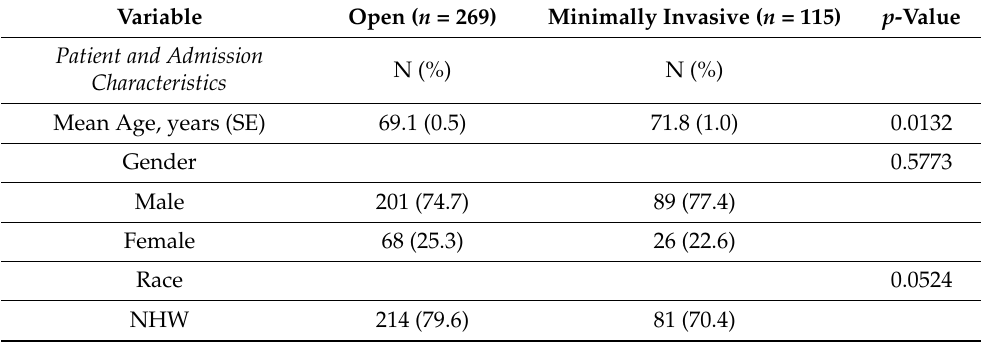
Table 4. Demographics of the sample according to surgical approach among P/D